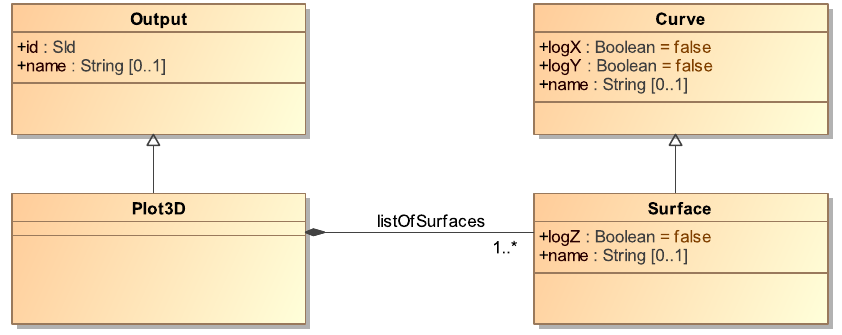
Figure 2.41: The SED-ML Plot3D class